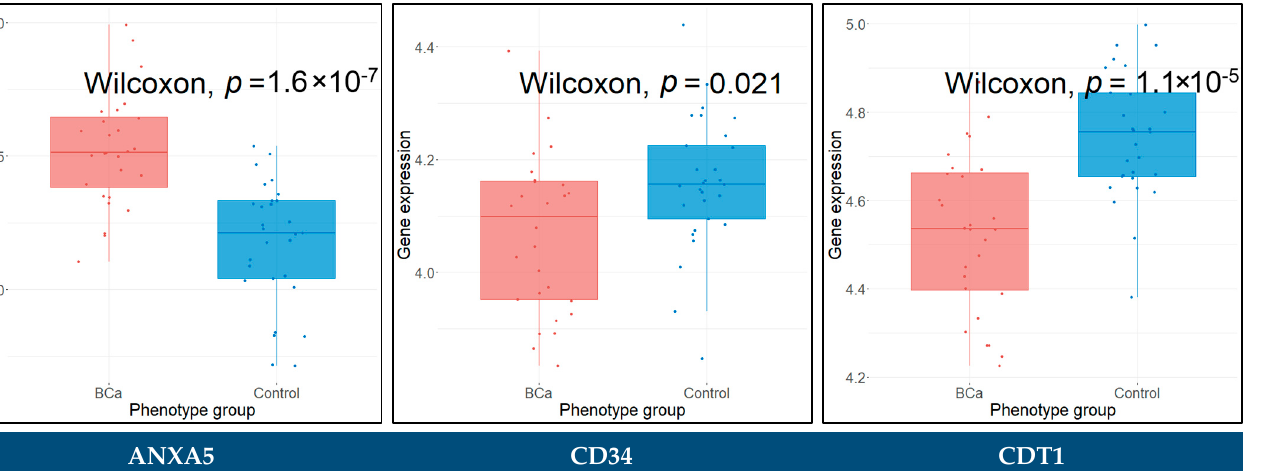
Figure 12. Significantly differentially expressed key hub genes in urine samples using the Wilcoxon rank sum test in GSE68020 ( n = 50).